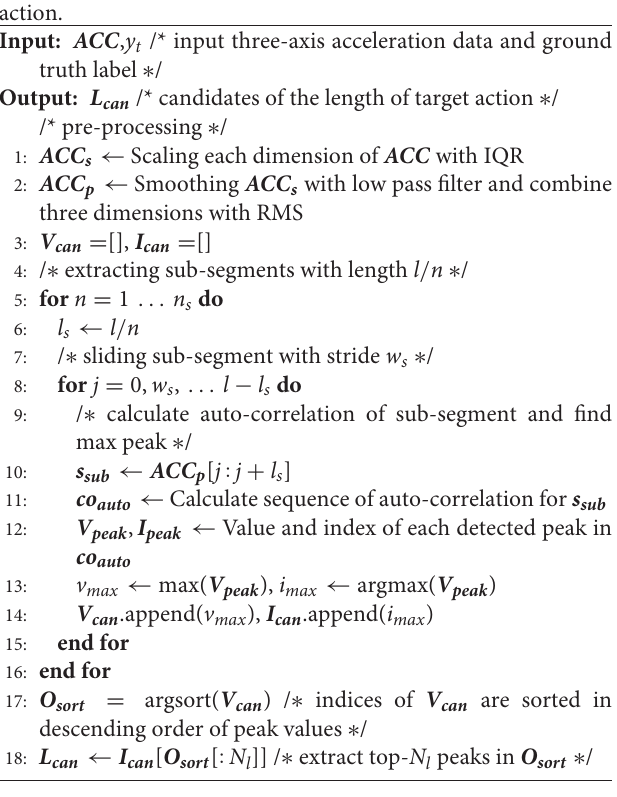
Algorithm 1 Determining candidates of the length of target